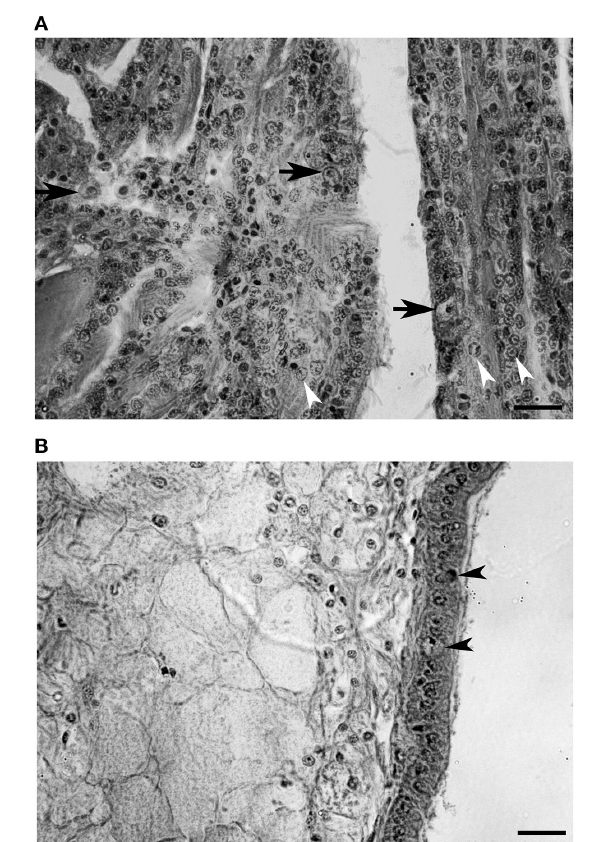
( Figure 8A ). Hypertrophied cells with a low nucleus-cytoplasm